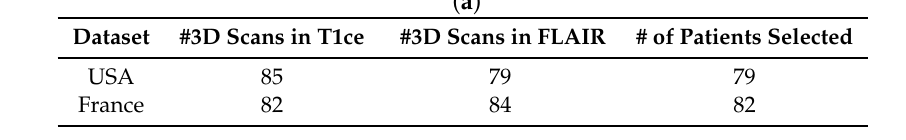
Table 3. Datasets. (a) Description of the datasets. (b) Description of data for two case